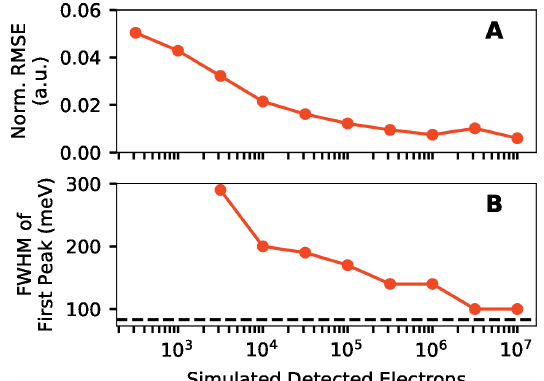
Figure 10 Quantification of the performance of PAX on the simulated data of Fig. 9. (A) Normalized RMS error (RMSE) of the estimated RIXS spectra versus the number of simulated detected electrons. (B) FWHM of the lowest energy loss peak in the estimated RIXS spectra as a function of the number of simulated detected